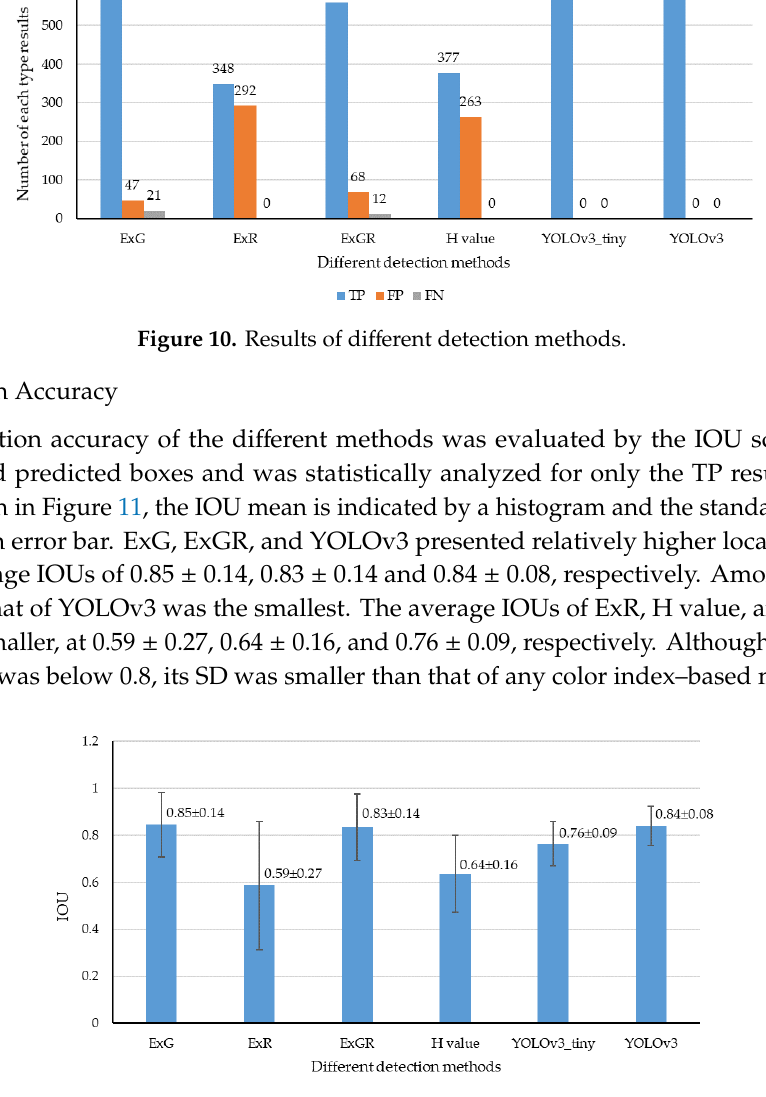
Figure 9. Samples of different identification results: ( a ) true positive (TP) sample; ( b ) false positive